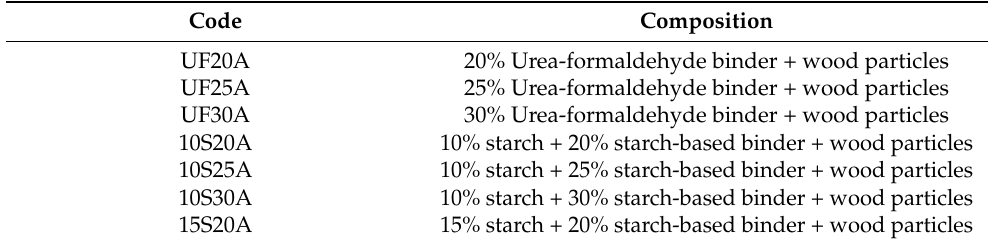
Table 3. Composition of particleboard with different percentages of starch with different percentages of adhesive